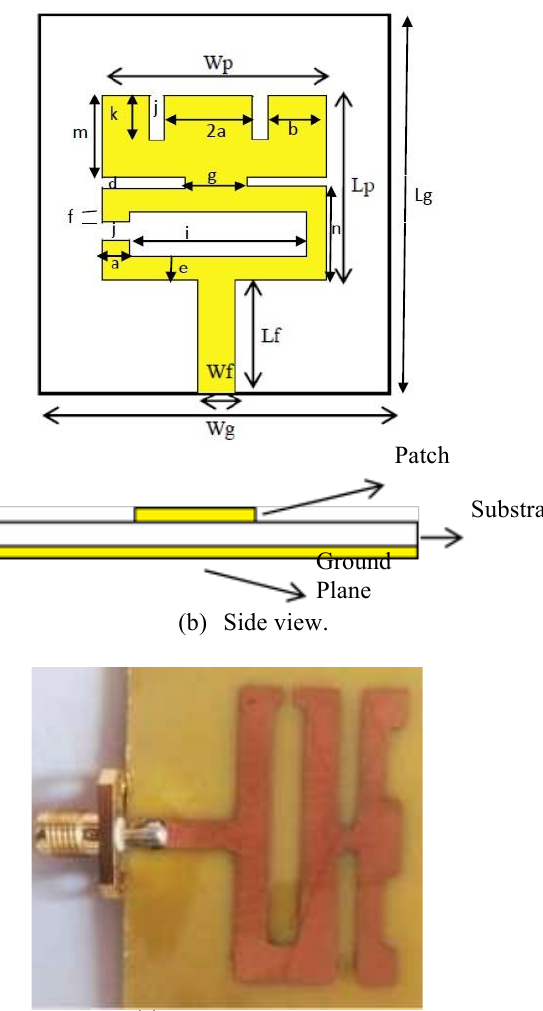
Figure 1: Geometry of the